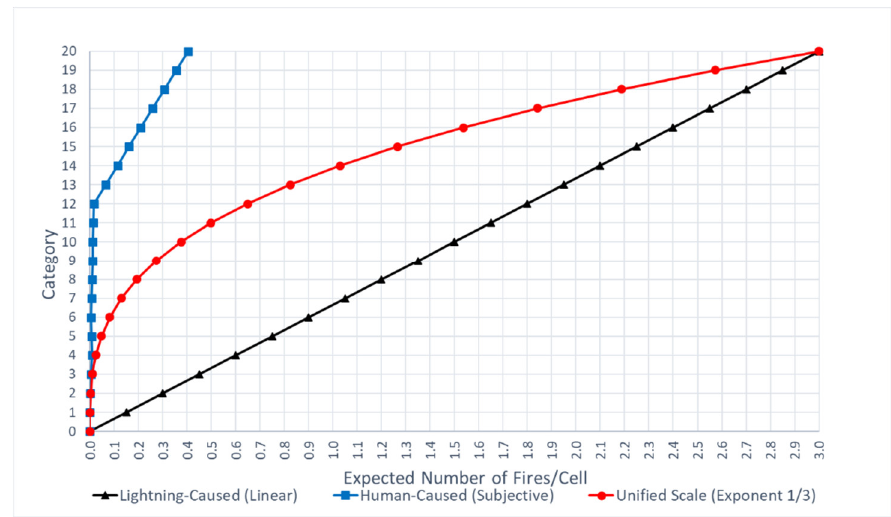
Figure 6. The original and unified fire occurrence prediction (FOP) classification scales. Because of order-of-magnitude differences in FOP, a separate scale was originally used for each cause: linear for lightning (black) and subjectively determined, irregular, nonlinear for human (blue). The unified scale (red) is a systematic, nonlinear one generated by a power function; a cube root in this example.